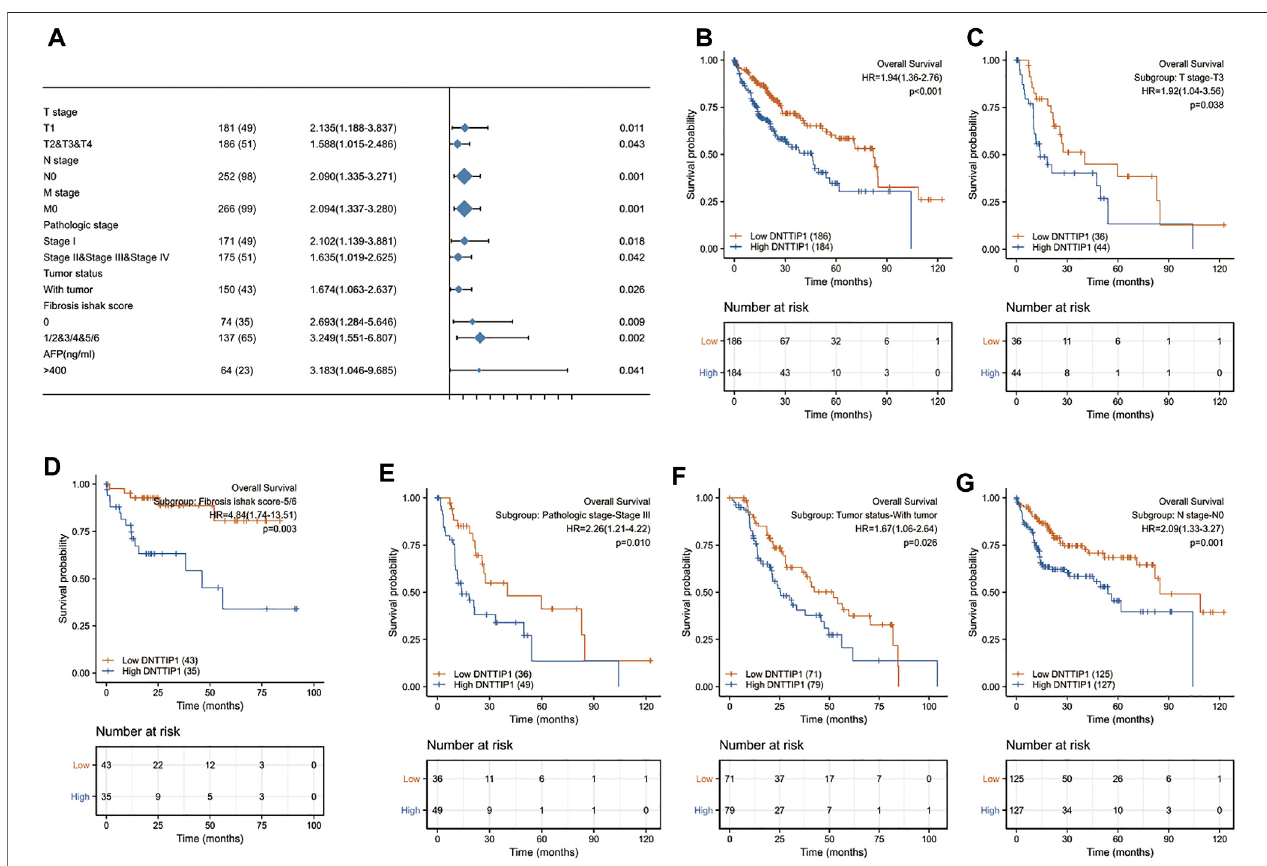
FIGURE6 | Prognostic value ofDNTTIP1 indifferent analyses. (A) Prognostic value ofDNTTIP1in overall survival ofHCC. (B) Forest plot of theprognostic value of DNTTIP1 in overall survival in different subgroups of HCC in TCGA – LIHC. (C – G) High expression of DNTTIP1 was associated with poor overall survival in different